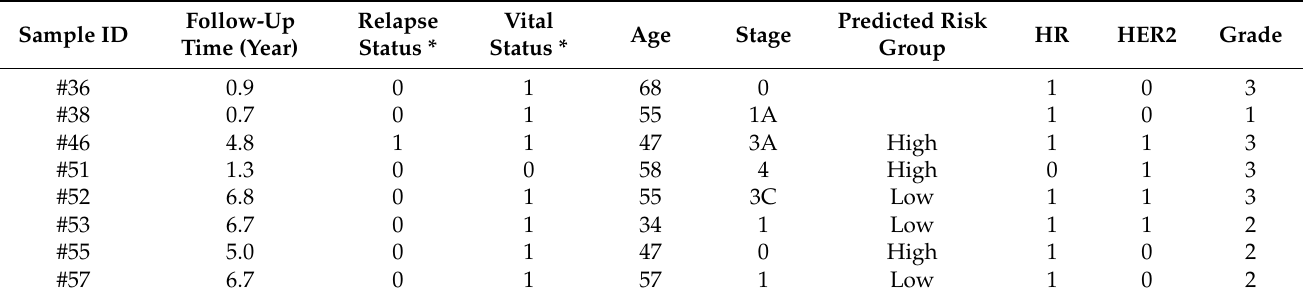
Table 1. Clinical features of 61 Taiwanese breast cancers with targeted